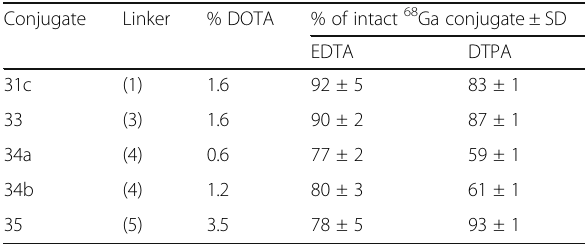
Table 5 Stability of 68 Ga conjugates at 37 °C in the presence of EDTA or DTPA at molar ratio 100:1 of competing ligand to conjugate ( n = 3) after 120 min